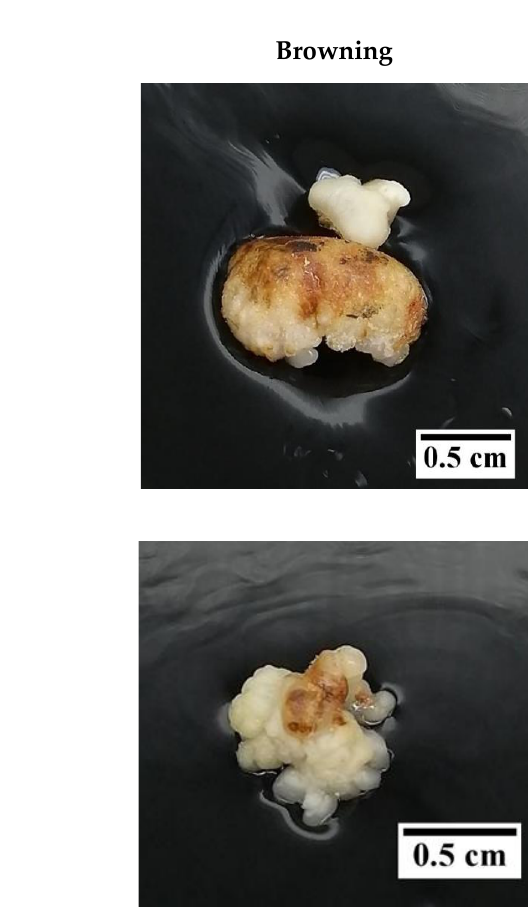
Figure 8. The effect of reduced nutrient concentration on the formation of compact embryogenic callus (EC), non-embryogenic callus (non-EC), and browning callus for the variety Indian Yellow Dwarf.